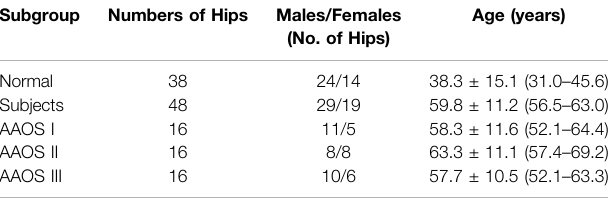
TABLE 1 | Demographic characteristics.